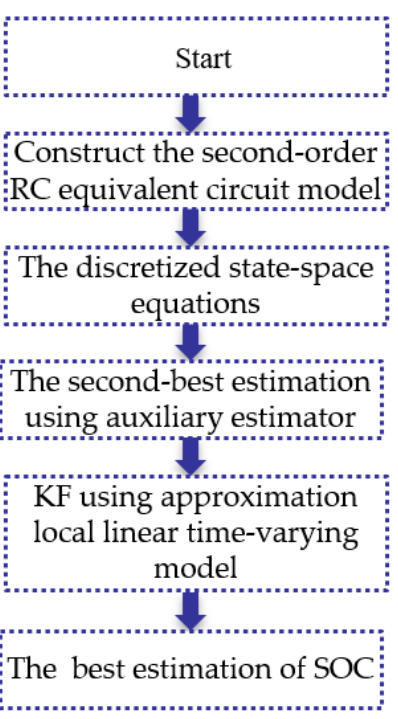
Figure 9. The flowchart of the SOC estimation using XKF.